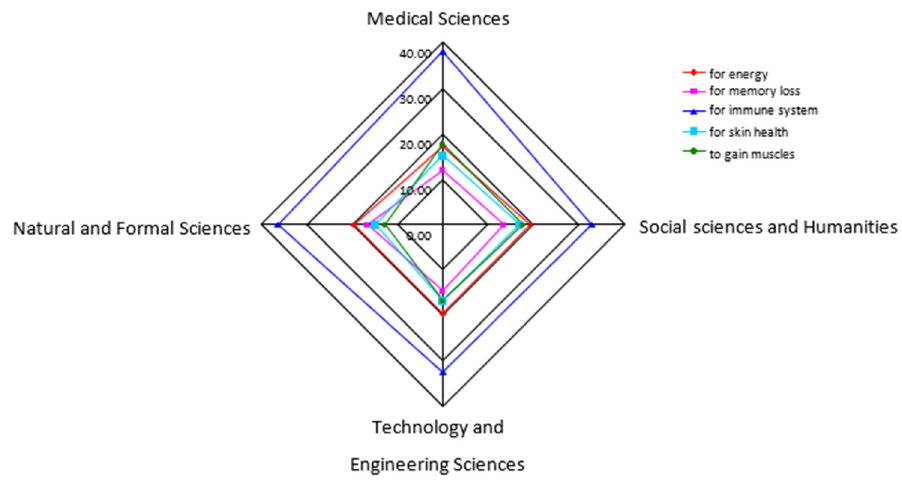
Figure 1. Most common purposes for the use of dietary supplements by students concerning different academic fields (% of students).